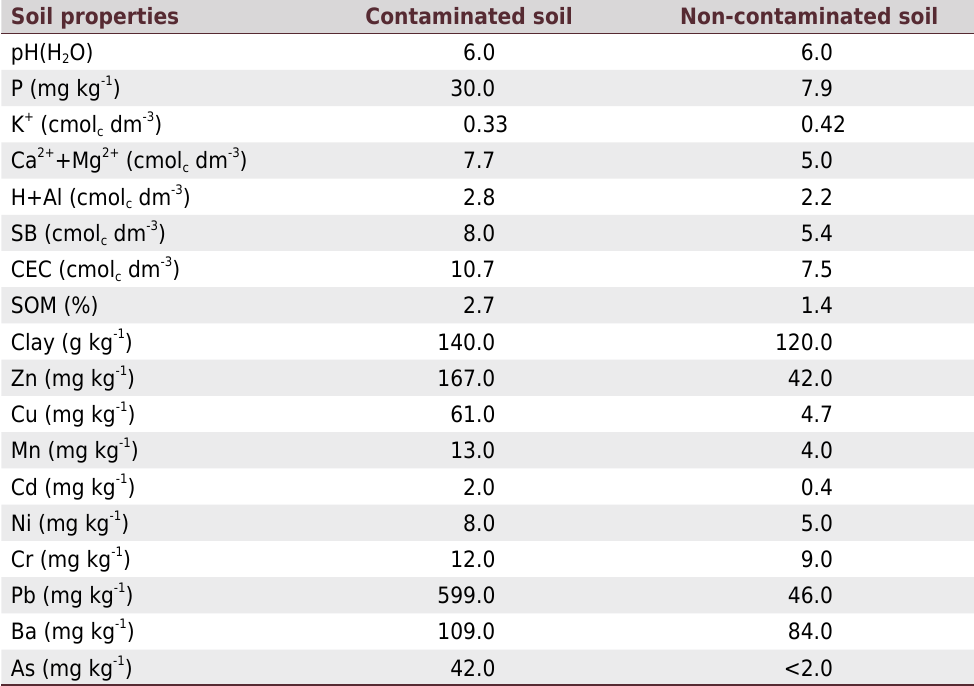
Table 1. Chemical properties, metals, and clay contents of the soils used in the experiment Soil